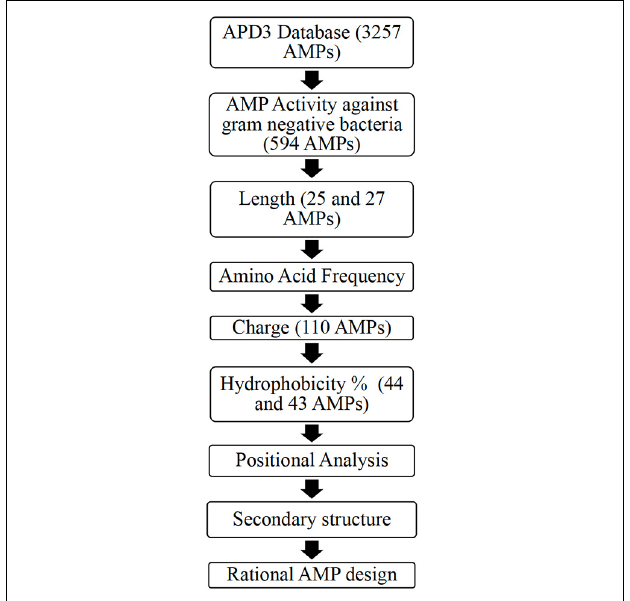
FIGURE 1 | A flowchart describing the ab initio rational AMP design process for Dataset 1 including an additional filter: positional analysis [Adapted from Mishra and Wang